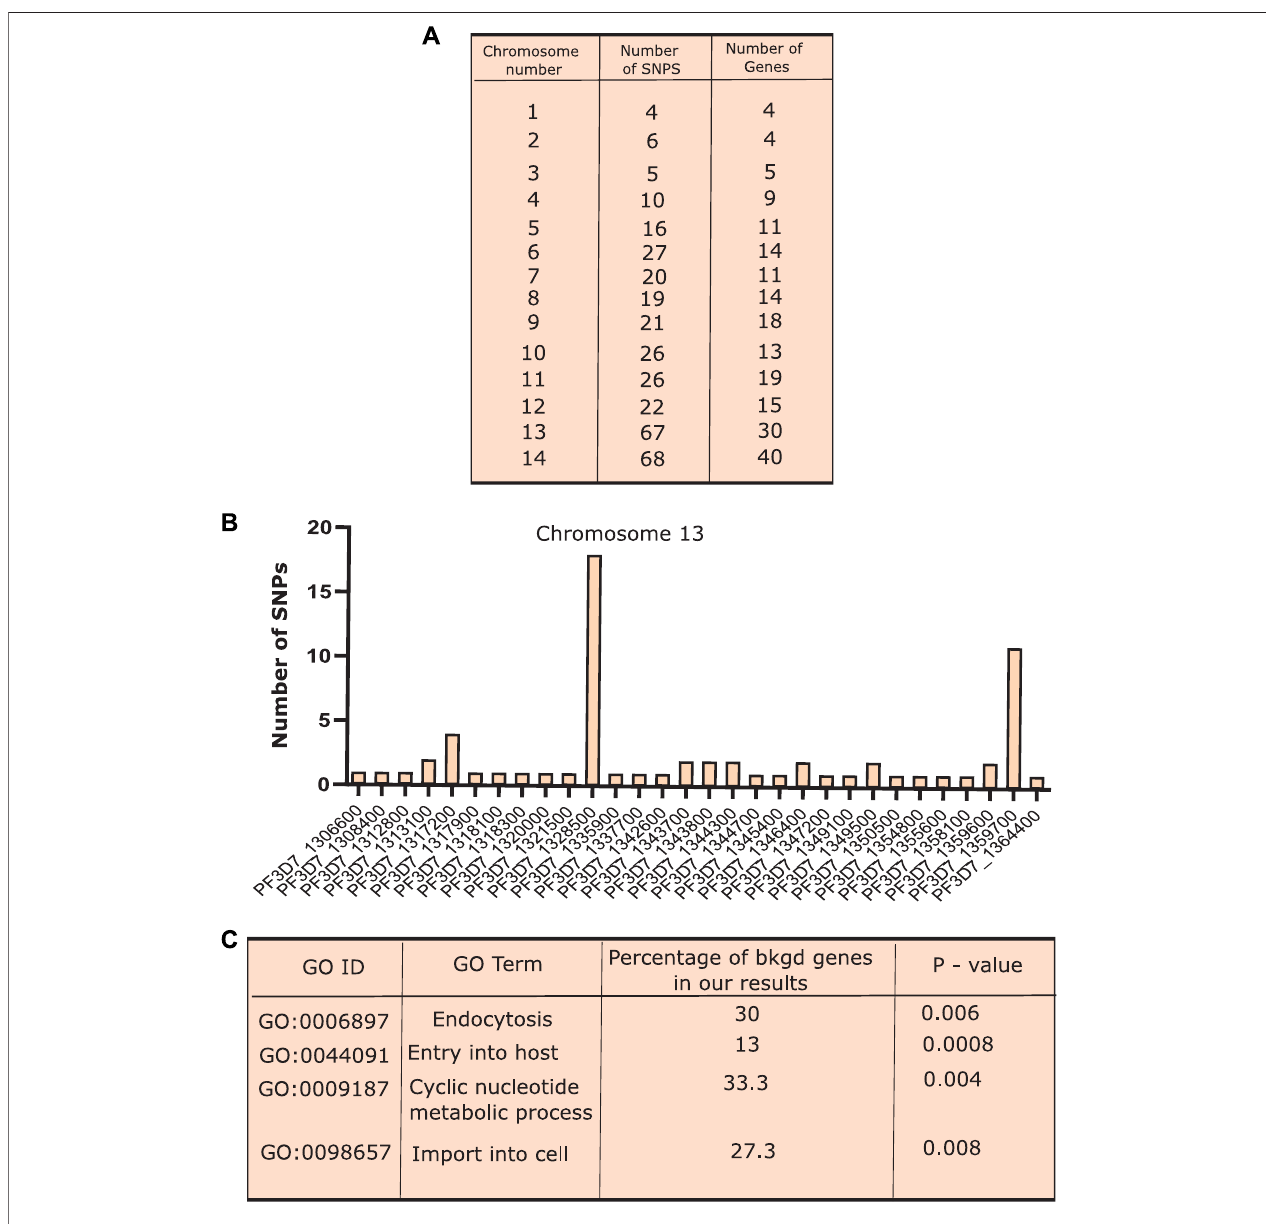
FIGURE 3 | Co-existence of different SNPs along with PfKelch13 mutations. (A) Exploration of background genomic variants co-existing with the K13 mutations in artemisininresistancewasidenti fi edusingthe359samples,whichshowoneofthethreeprimeK13mutations(C580Y,R539T,andY493H).InorderforanSNPtobe fi ltered forco-existencewithK13mutations,ithadtobepresentinatleast75%ofK13mutantisolates.VariantannotationwasdoneforalltheSNPsusingthetoolsnpEFFandonly those SNPs that were non-synonymous mutation were considered for further analysis. Table presenting the number of SNPs identi fi ed present in the 75% of the K13 mutantsisolatesandpresentinlessthan25%ofthesensitive(K13mutantabsent)isolatesinvariouschromosomes. (B) BargraphshowingthenumberofSNPspresenton the different genes over chromosome 13. (C) Gene ontology performed for the genes showing SNP co-existing with K13 mutations. Different biological processes like “ endocytosis ” , “ locomotion ” , “ cell division ” , and “ response to drug ” were found to be enriched. Plots were generated using R and GraphPad.